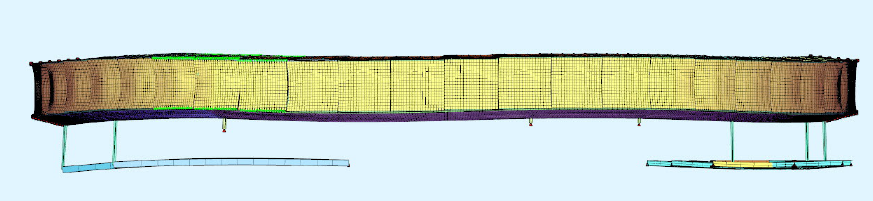
Fig. 13: Shell element model of one half of the walkway under maximum loads, displacements are scaled up.